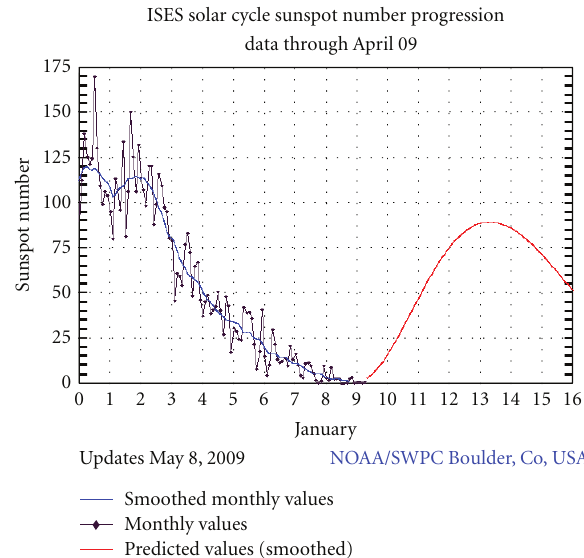
Figure 9: The updated international prediction of SC24 dated April 9, 2009